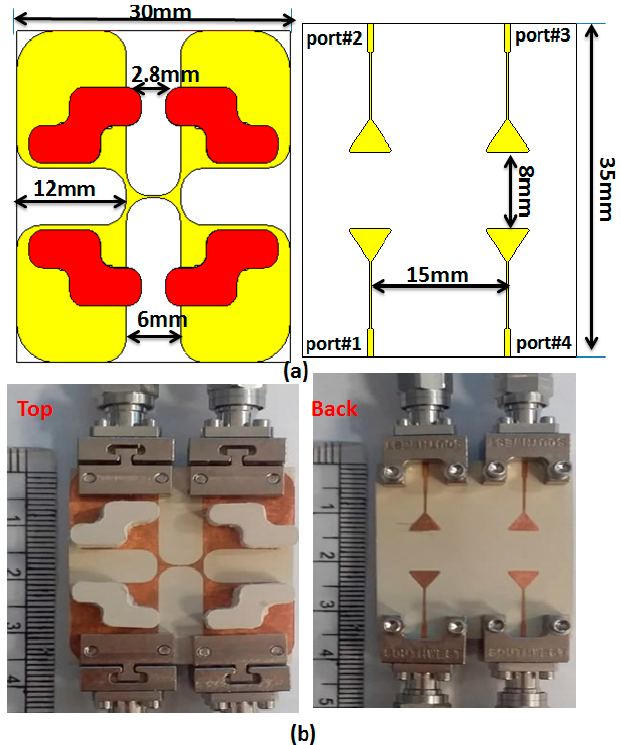
Figure 9. Proposed four-port DRA layout: ( a ) 2D front/back view; ( b ) photo of the fabricated model. Figure 9b shows the fabricated prototype of the CP MIMO DRA. Figure 10 shows the electric field distribution in the antenna structure without and with DGS. The field distribution shows the coupling between the adjacent radiating DR elements in a case when four ports were applied. Figure 10 also shows that there was high coupling in the case of usage of the full ground structure. The usage of DGS improved the isolation between ports. The color bar shows that the red field did not appear in the second slot area when DGS was applied. Especially at lower frequencies, this coupling was stronger in the case of a four-port structure in comparison to the two-port structure shown in Figure 6. At higher frequencies, the spacing between radiating elements became comparable to the half-wavelength; hence, the isolation was not much affected. The S-parameter response in these two cases was expected to be as usual, so it is not reported in this manuscript. The field distribution is only reported at lower frequencies and could be assumed at higher frequencies. The four-port antenna contained four radiating elements. The effect of horizontal separation between the radiating elements of the antenna having two ports was observed earlier in this manuscript (Figure 8). The effect of vertical separation being represented by Y is shown in Figure 11a–e. The variation in Y did not significantly affect the reflection coefficient. The variation in Y may affect the phase difference between the generated orthogonal modes desired for generating the CP response; thus, the AR response was varied. The increment in Y enhanced the isolation between radiating elements, which were separated by Y but not by X, as expected. The port parameters were measured using vector network analyzer ZVA 67 to validate the simulated results, as shown in Figure 12. The variation in the S parameter response at each port was due to the fabrication tolerances. A 10 dB bandwidth of 38% (8.5–12.5 GHz) was obtained from the antenna. The isolation between ports is illustrated in Figure 11e. The measured isolation results had a level higher than 20 dB in the operating band. The simulated and measured results of 3 dB AR are displayed in Figure 13. The antenna had a bandwidth of 10.41% ( 9.1–10.1 GHz ) and 9.3% ( 9.2–10.1 GHz ) ,